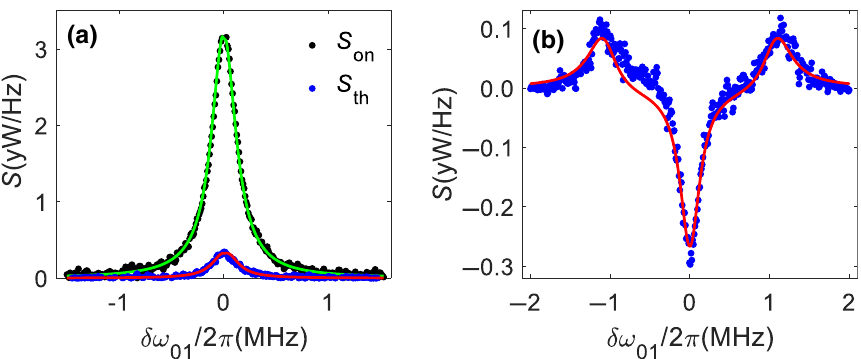
FIG. 3. Thermal spectrum. (a) Power spectral density (PSD) of the output field where the results with and without a strong drive are S on and S th , respectively. Units are yW/Hz = 10 − 24 W/Hz and S = 2 π S (ω) . The solid curves are the corresponding fits to Eqs. (7) and (8). The Rabi frequency used for S on on the | 0 (cid:3) ↔ | 1 (cid:3) transition is (cid:5)/ 2 π ≈ 8.8 MHz. (b) PSD from Autler-Townes splitting. The solid curve is calculated from theory. In both (a) and (b), dots are from the experimental data. The Rabi frequency used for the drive on the | 1 (cid:3) ↔ | 2 (cid:3) transition is (cid:5)/ 2 π ≈ 1.5 MHz. Note that the PSD in (a) is subtracted by the background when tuning the qubit frequency away through the external magnetic flux, whereas in (b) the PSD is the difference between the thermal spectra with and without the drive on the | 1 (cid:3) ↔ | 2 (cid:3)